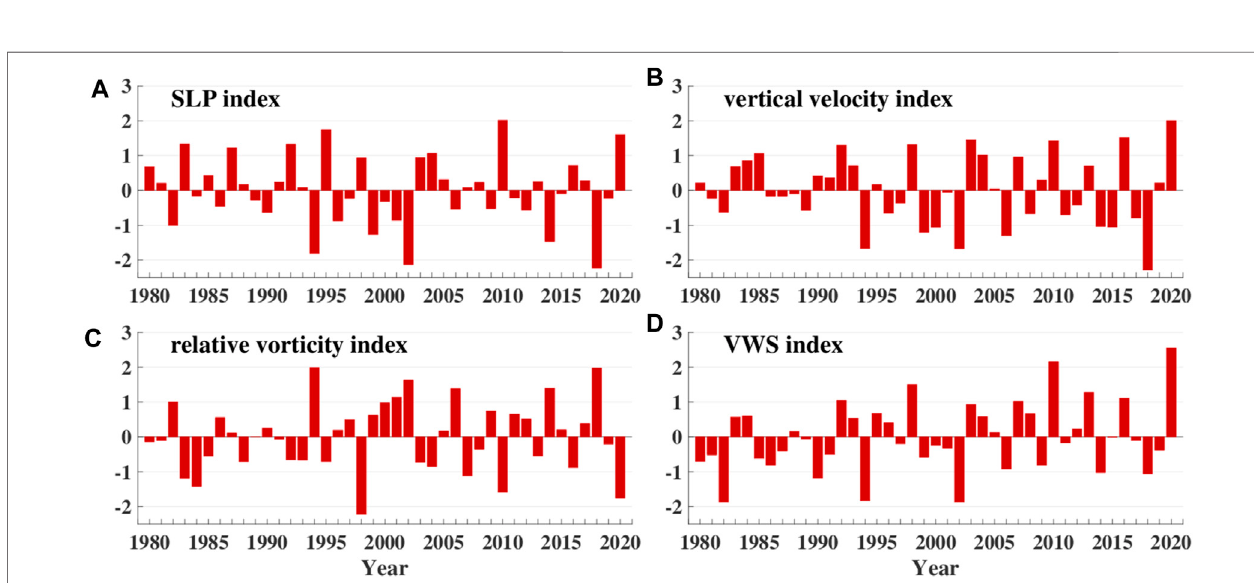
FIGURE4| Interannualvariabilityofthe (A) .SLPanomalyaveragedovertheregion(10 ° – 25 ° N,90 ° – 150 ° E), (B) 500-hPaverticalvelocityanomalyaveragedoverthe region (12.5 ° – 22.5 ° N, 100 ° – 150 ° E), (C) 850-hPa relative vorticity anomaly averaged over the region (12.5 ° – 22.5 ° N, 100 ° – 125 ° E), and (D) VWS anomaly averaged over the region (10 ° S – 15 ° N, 100 ° – 150 ° E), affecting the TCGN over the WNP during 1980 – 2020.